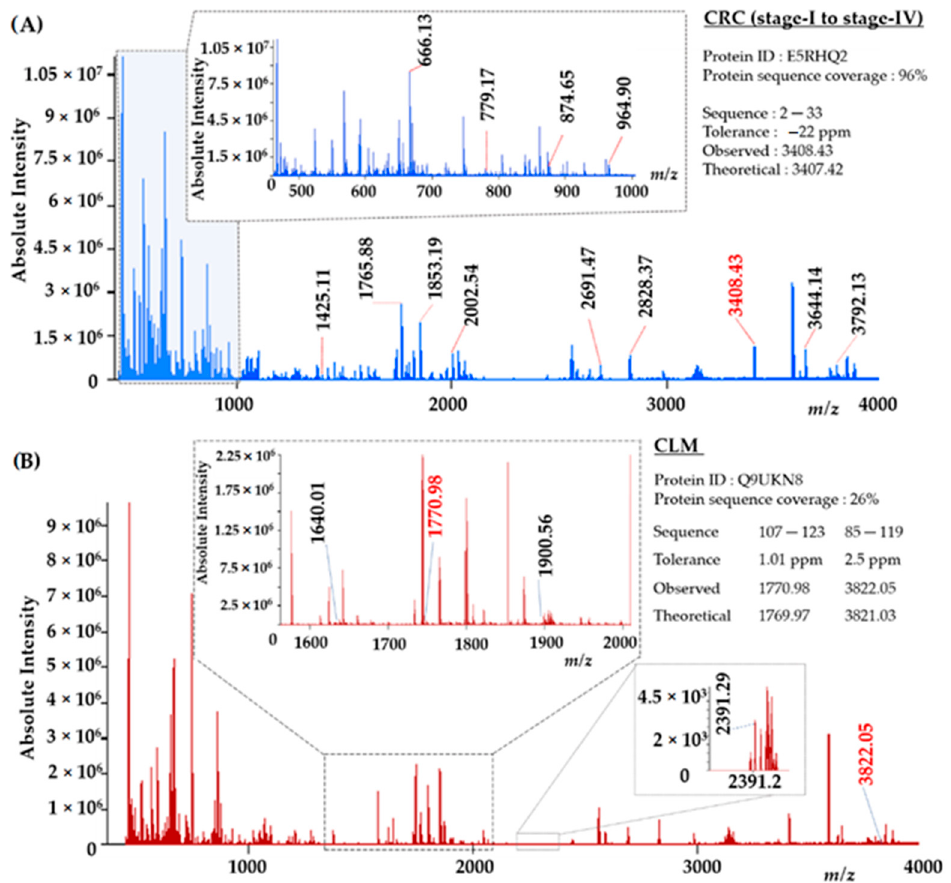
Figure 3. NIMS-FT-ICR-MS identified the top discriminative ions that can differentiate CRC disease from the CFI group. We interpreted the m/z spectral value of peptide ions (labelled in red) that showed a high score of sequence coverage, which matches protein hits (MASCOT). ( A ) We identi- fied m/z 3408.43 (±2 ppm) matching PP2A was upregulated in CRC all stages (stage-I to IV) group compared to CFI. ( B ) Ions m/z 1770.98 (±1.01 ppm) and m/z 3822.05 (±2.05 ppm) matching ATF3 protein was upregulated in the CLM group compared to CFI.